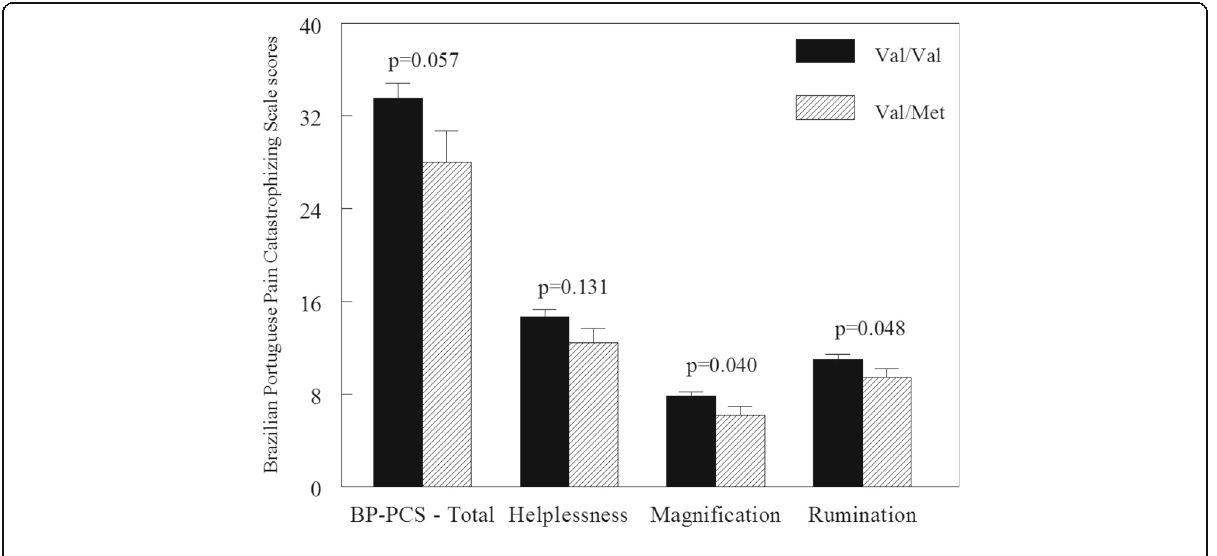
Fig. 1 Pain catastrophizing scale (total and sub-scales ’ scores) in the FM sample according to Val66Met genotypes. Notes. Data are shown as mean and error standard of mean (S.E.M.)